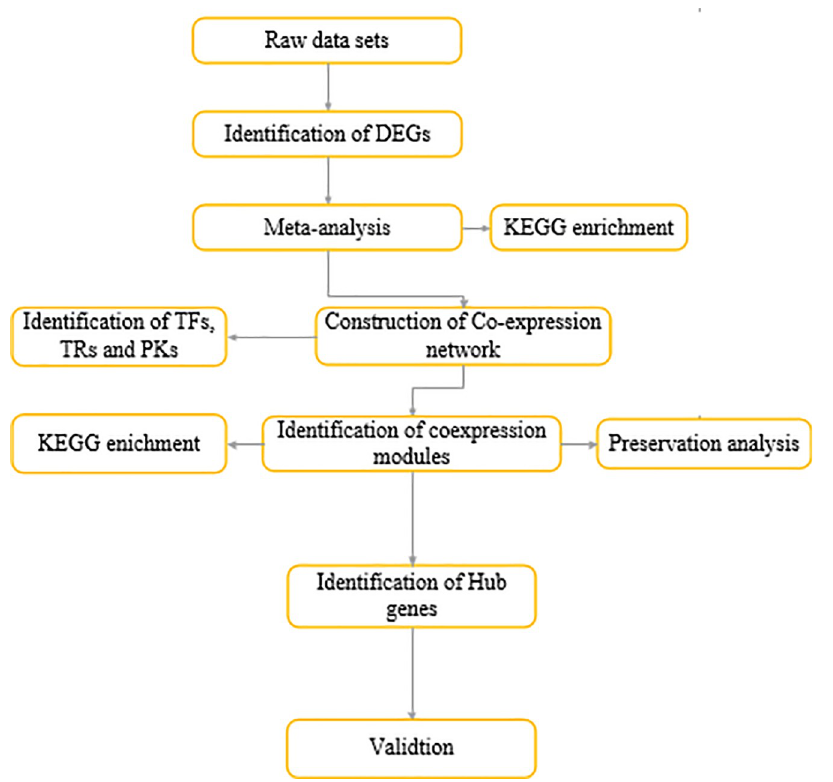
Fig 1. Flow chart of applied systems biology approach in current